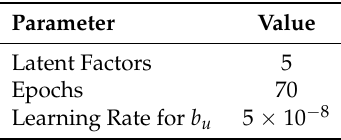
Table 2. SVD Hyperparamter